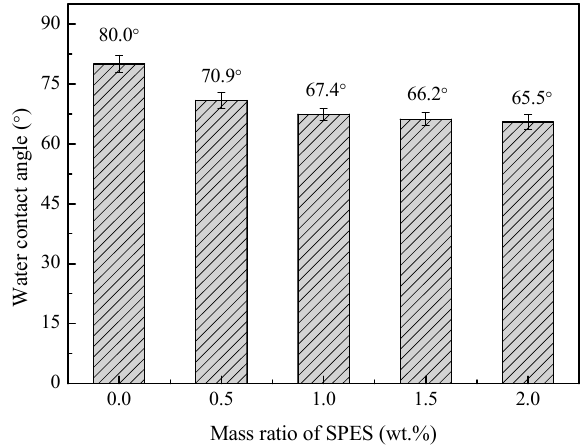
Figure 10. The static pure water contact angles of the prepared membranes via non-solvent assisted RTIPS.